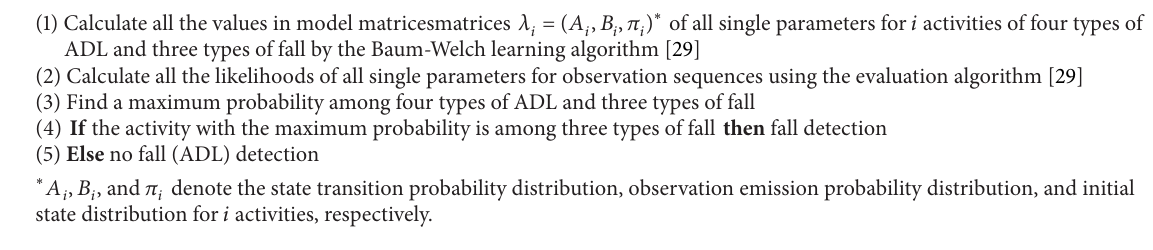
Algorithm 2: HMM algorithm for fall detection.